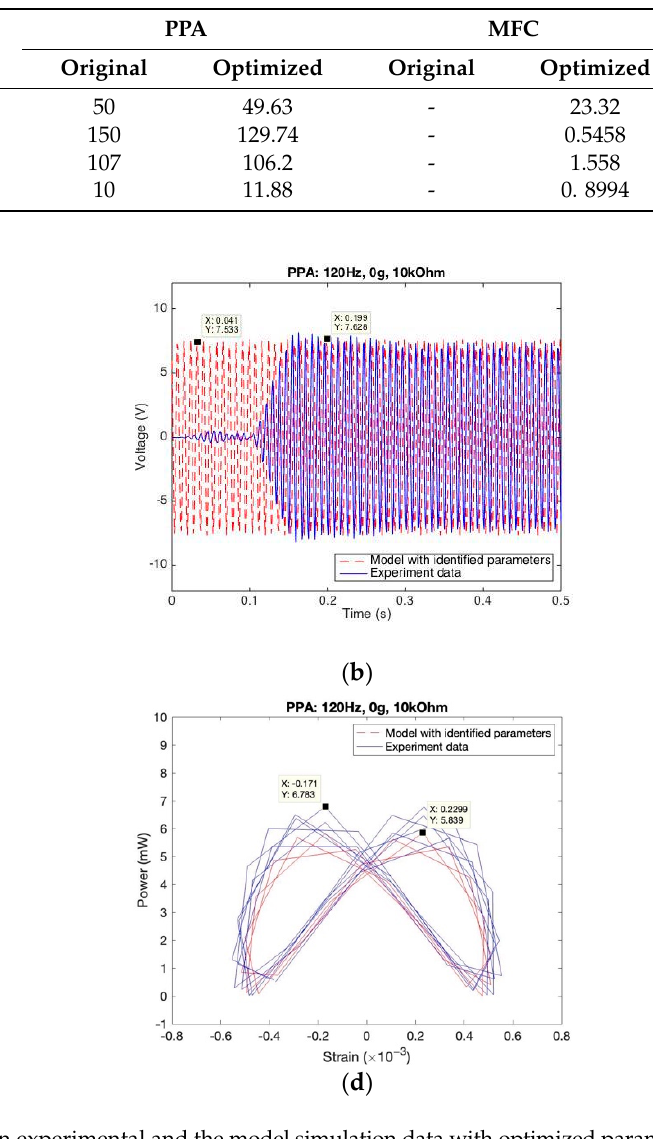
Figure 14. Comparison between experimental and the model simulation data with optimized parameters in PPA. ( a ) Current vs. time; ( b ) Voltage vs. time; ( c ) Voltage vs. strain; ( d ) Power vs. strain.